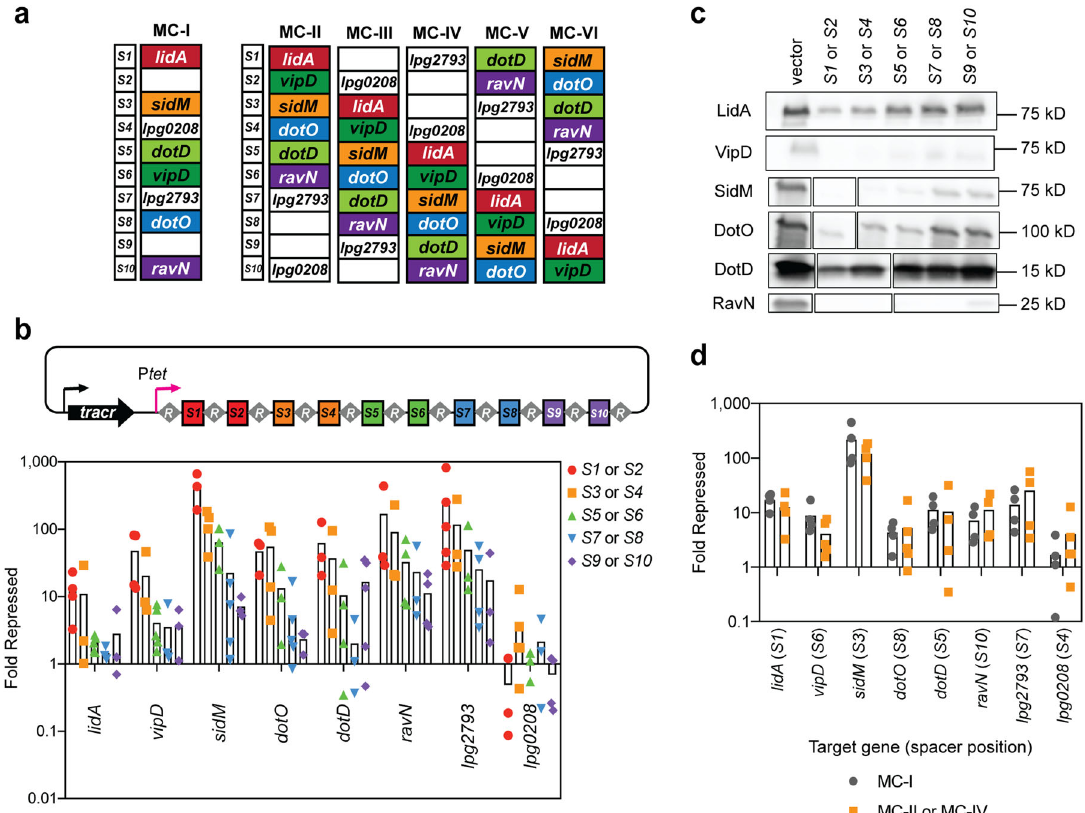
Fig. 3 The effect of spacer position on gene silencing by P tet - MC arrays. a Additional P tet - MC constructs, MC-II through MC-VI, were made to test the effect of spacer position and environment on gene silencing. Each spacer is present in either position S1, S3, S5, S7 , and S9 or S2, S4, S6, S8 , and S10 . b RNA was extracted from Lp02( dcas9 ) bearing either the empty vector or an MC construct after axenic culture ( + 40 ng/mL aTC). qPCR was used to measure mRNA levels of target genes. Fold repression was determined using ΔΔ C T . Bars indicate the mean of multiple replicates shown as individual data points. A value of 1 indicates that the mRNA level was the same in both strains. c Immunoblot analyses were performed on pellets collected from the same cultures. The blot shown is a representative of three replicates, with bands rearranged corresponding to spacer position. Original immunoblots and ICDH loading controls are shown in Supplementary Fig. S3. d RNA was extracted from Lp02( dcas9 ) bearing either the vector or the MC-I construct after axenic culture ( + 40 ng/mL aTC). qPCR was used to measure mRNA levels of target genes. Fold repression was determined using ΔΔ C T and plotted in comparison to data fi rst shown in b